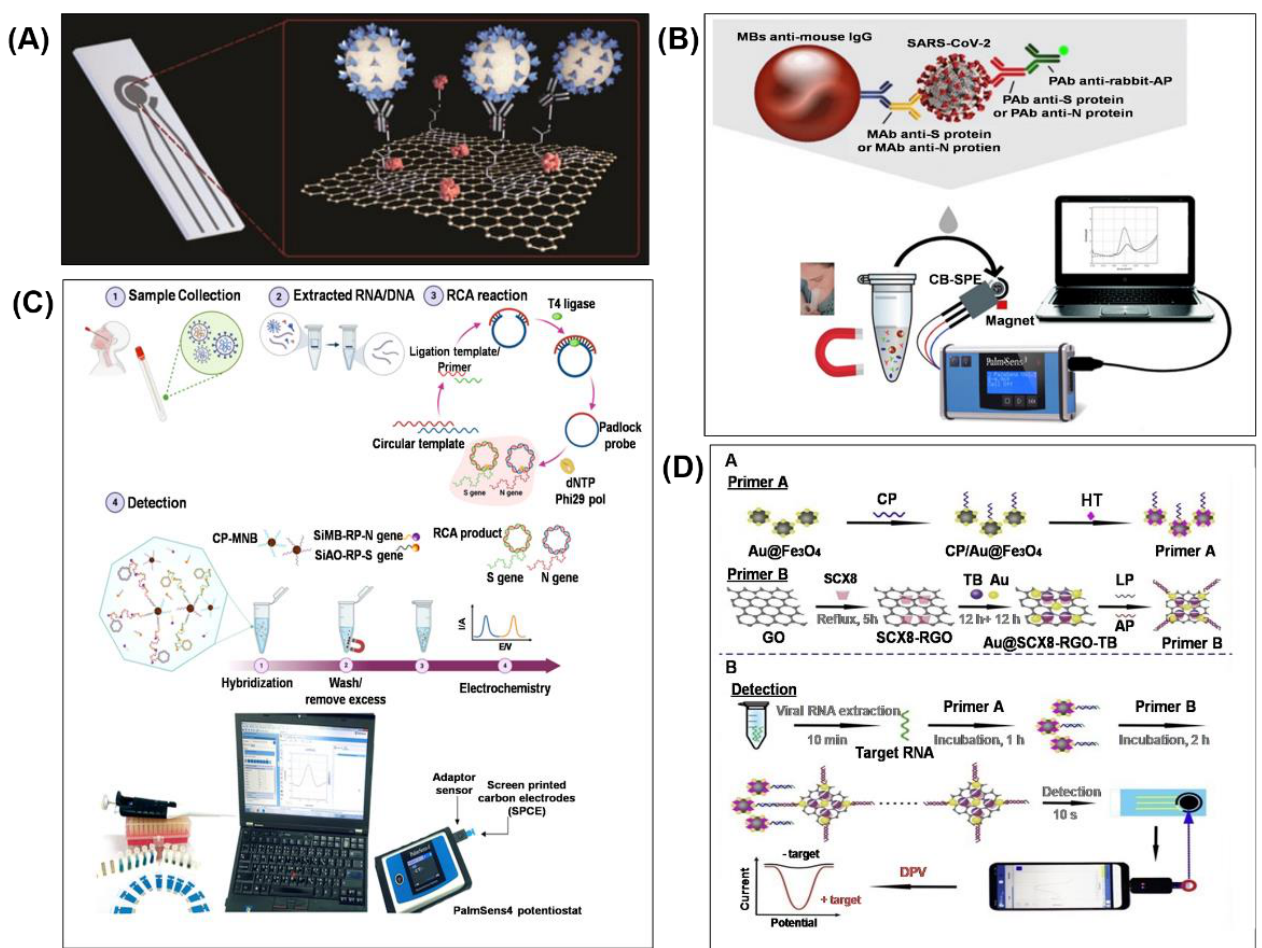
Figure 5. Electrochemical biosensor for SARS-CoV-2 detection. ( A ) Graphene-based electrochemical biosensor. Reprinted with permission from [39]. ( B ) MBs-based electrochemical biosensor. Reprinted with permission from [40]. Copyright 2020, Elsevier B.V. ( C ) Electrochemical biosensor with RCA of the N and S genes. Reprinted with permission from Lertanantawong, B (2021). Copyright 2021 Springer. ( D ) Smartphone-based supersandwich-type electrochemical biosensor. Reprinted with permission from [88]. Copyright 2021, Elsevier B.V.